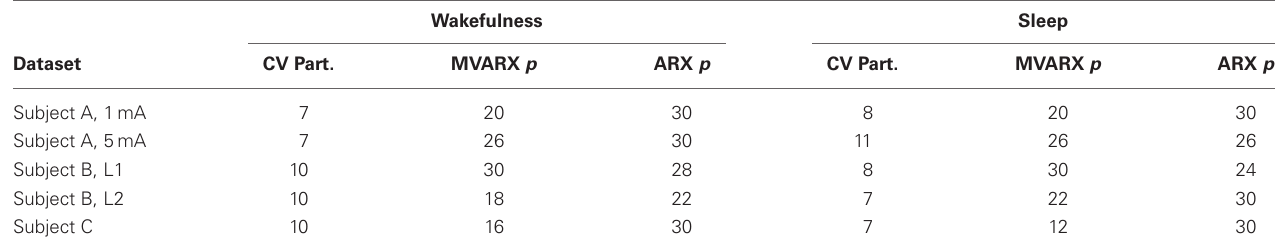
Table 2 | Model order parameters for wakefulness and sleep data